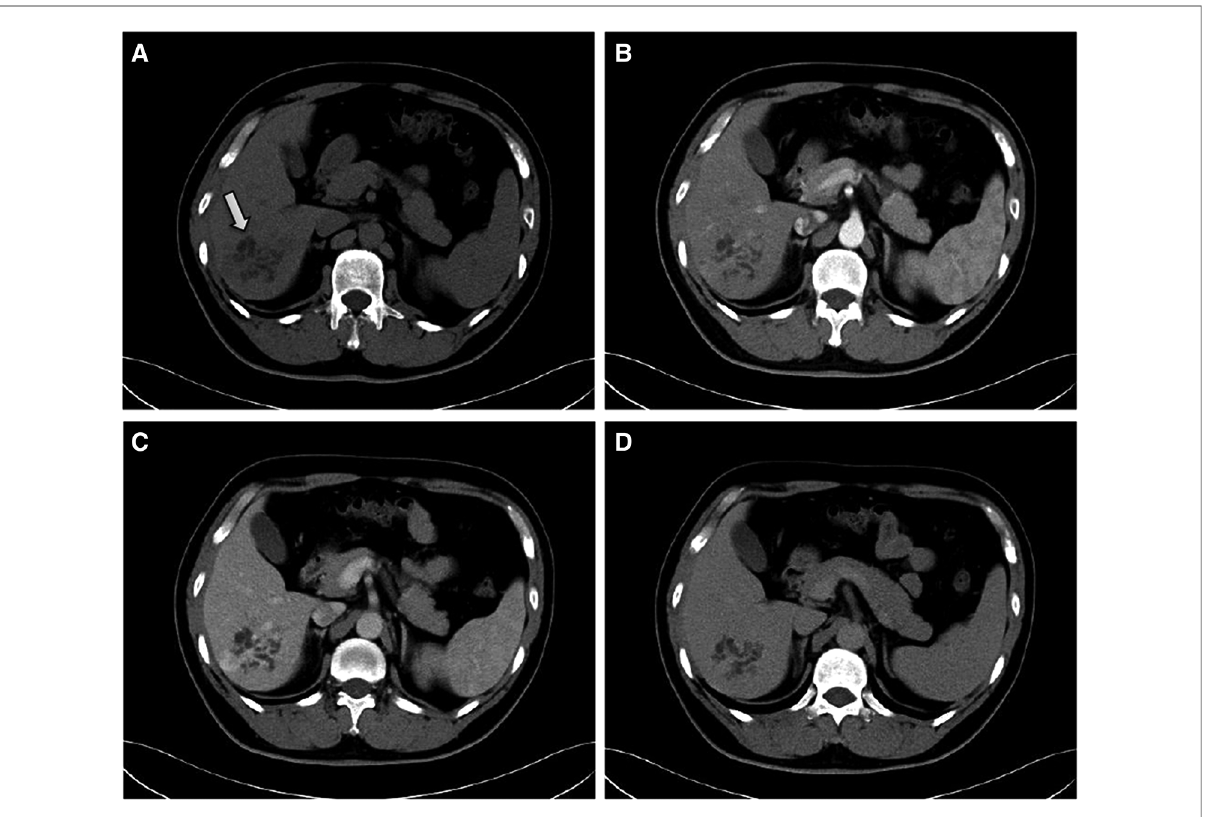
FIGURE 1 Contrast-enhanced CT fi ndings. ( A ) plain scan, ( B ) arterial, ( C ) portal and ( D ) equilibrium phases, respectively. The CT scan shows a honeycomb-like cystic – solid lesion in segment 6 of the liver (white arrow). The cystic components show no enhancement during the arterial phase. The solid components are more enhanced compared with the normal hepatic parenchyma in the arterial and portal phases and are consistent with the normal hepatic parenchyma in the equilibrium